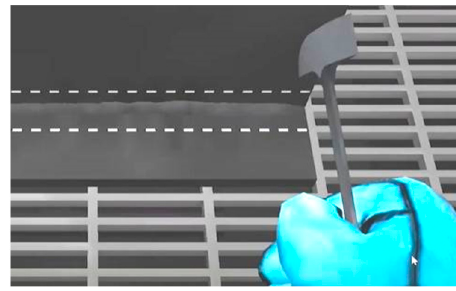
Figure 8. Tool for Removing Slag from a Weld Bead, a Slag Hammer.